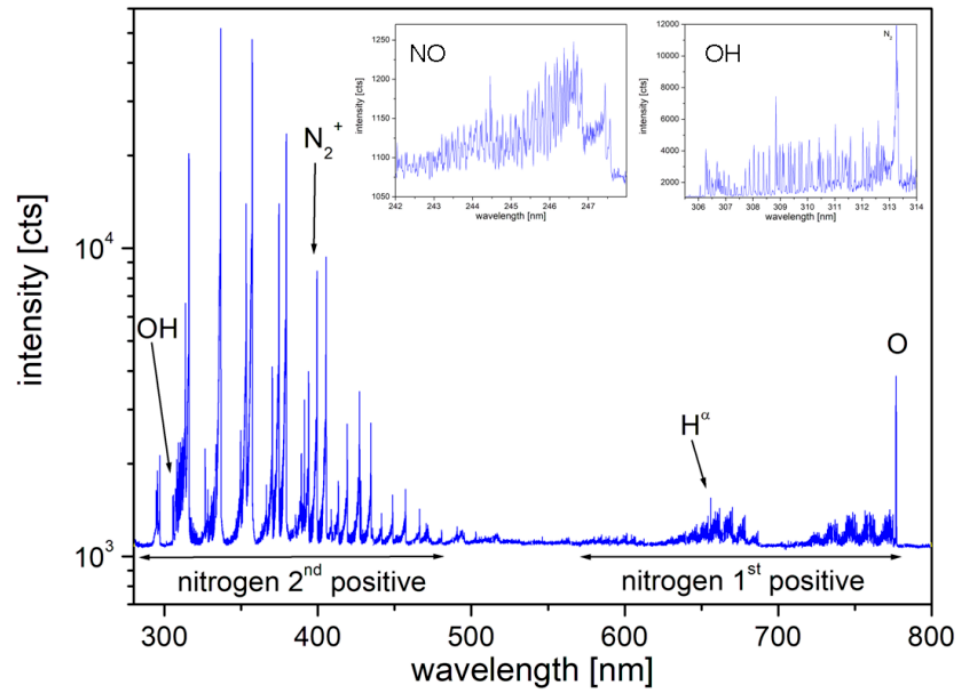
Figure 3. Example of the discharge emission spectrum.